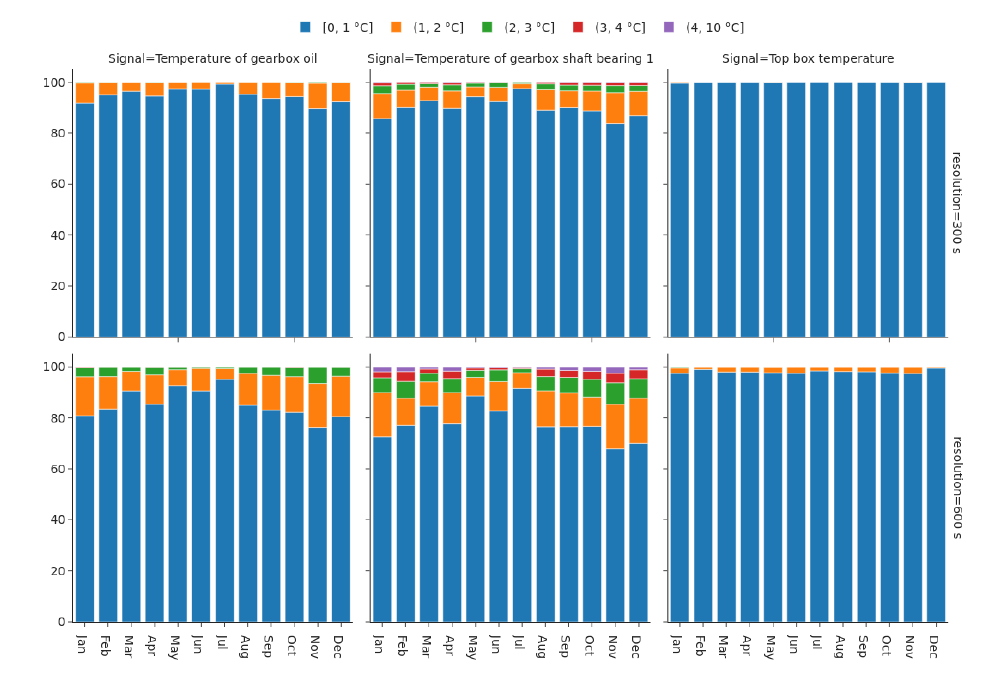
Figure 8. Information loss results for all turbines partitioned by months. Two time resolutions are provided: 300s in the top row, 600s in the bottom row. Error bins are temperature intervals measured in degrees